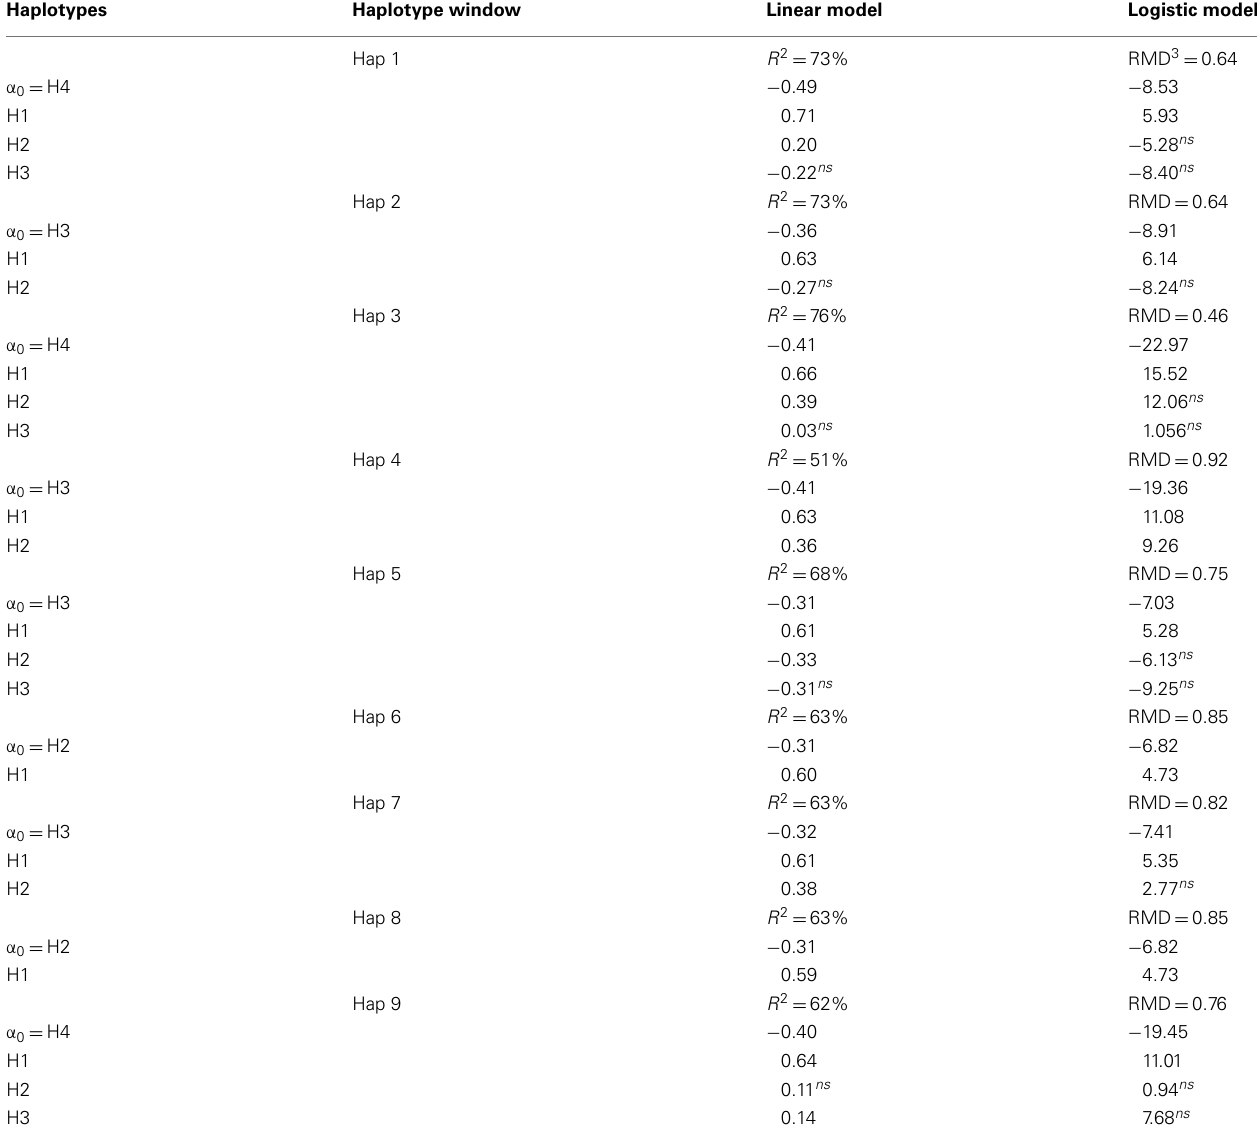
TableA2 | Haplotype substitution effects on linear and logistic scales for disc calcification scored as binary case/control.